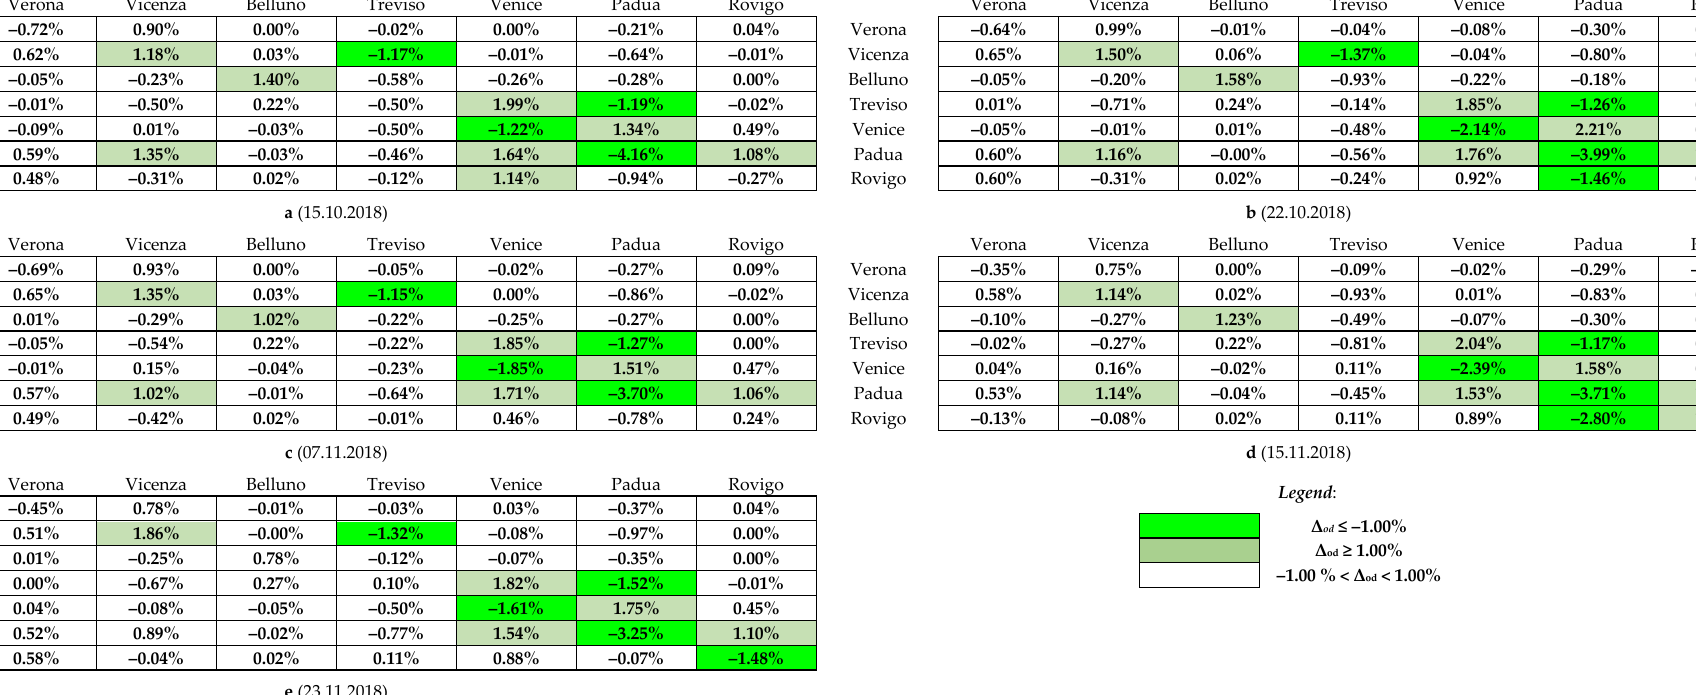
Figure 5. Comparison of O-D flows specific weight between sampling and ISTAT data.